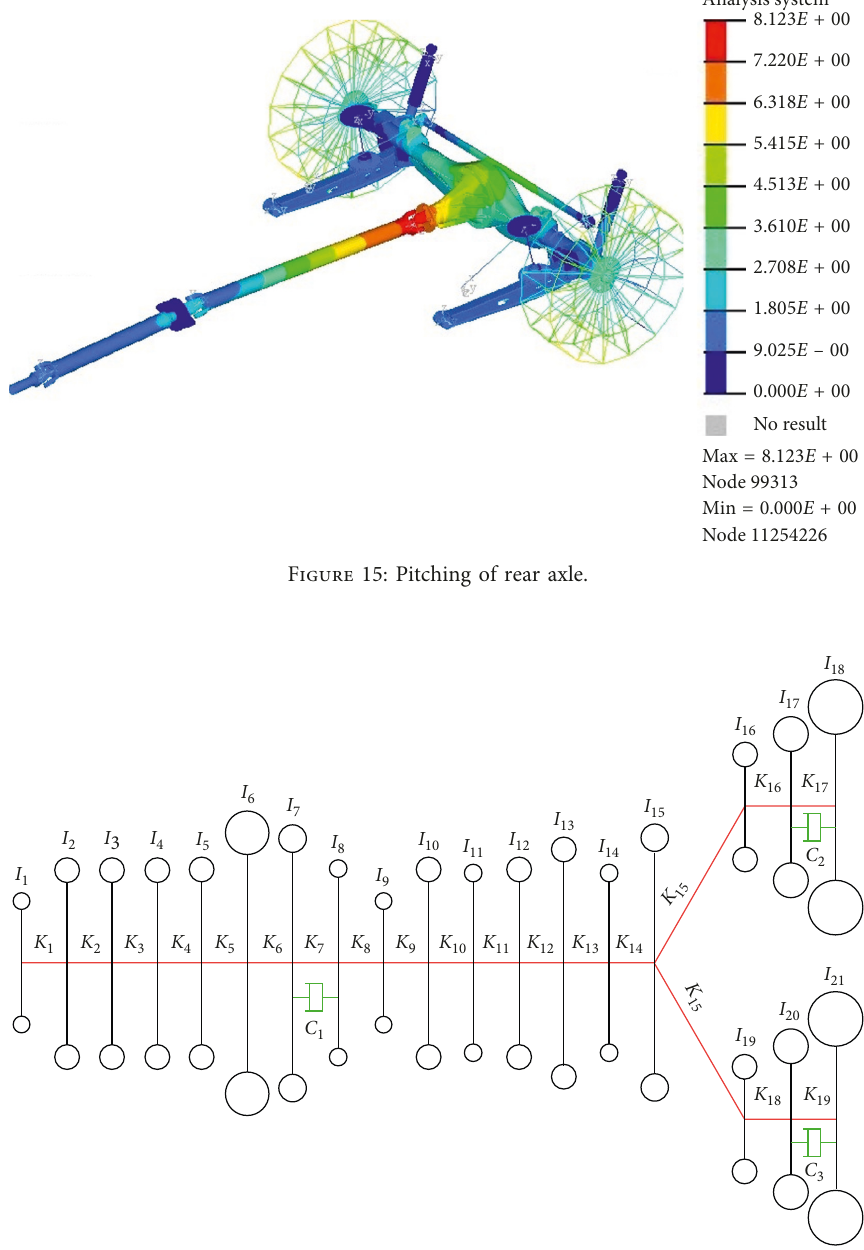
Figure 16: Lumped-parameter torsional vibration analysis model of minivan